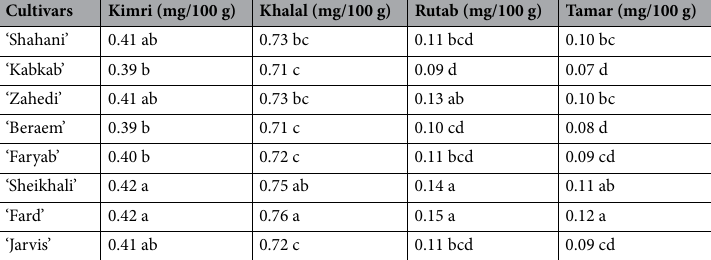
Table 6. The amount of carotenoids of ’Piarom’ date fruit in kimri, khalal, rutab and tamar stages after pollination of eight pollinating cultivars. Different letters within columns indicate significant differences according to Duncan’s multiple range test (p < 0.05).